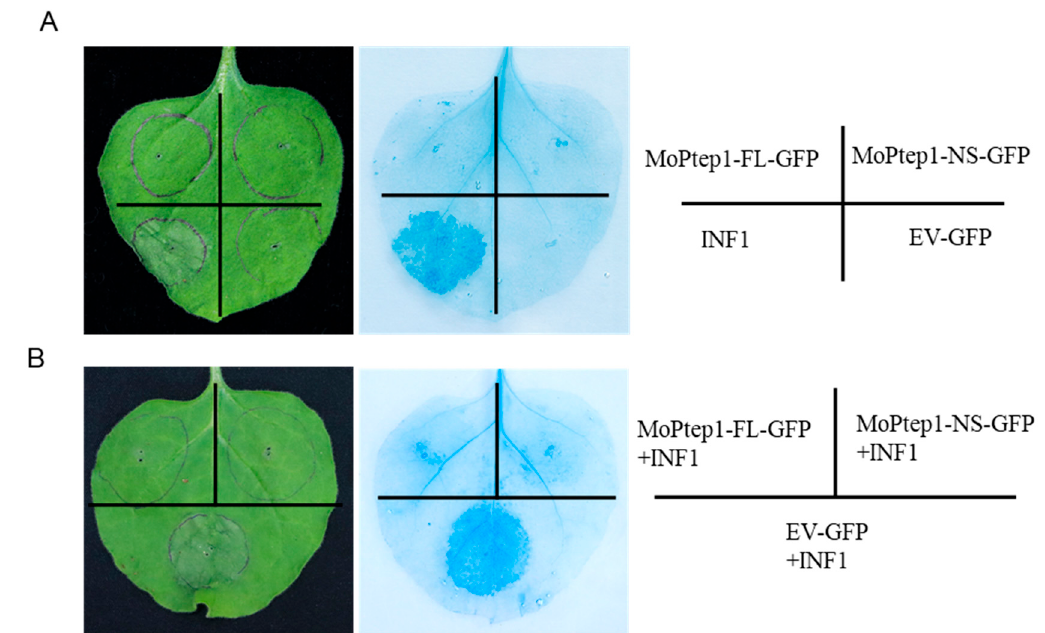
Figure 7. MoPtep1 inhibits Cell Death in N. benthamiana . ( A ) MoPtep1-FL-GFP, MoPtep1-NS-GFP, EV-GFP, and INF1 were transiently expressed in N. benthamiana , separately. ( B ) MoPtep1-FL-GFP and MoPtep1-NS-GFP inhibit INF1-induced cell death in N. benthamiana . INF1 was infiltrated into N. benthamiana 24 h after the MoPtep1 injection. Photographs were taken 3 days post agroinfiltration (dpa). The right pictures indicate the trypan blue staining. The agroinfiltration experiments were repeated at least three times.